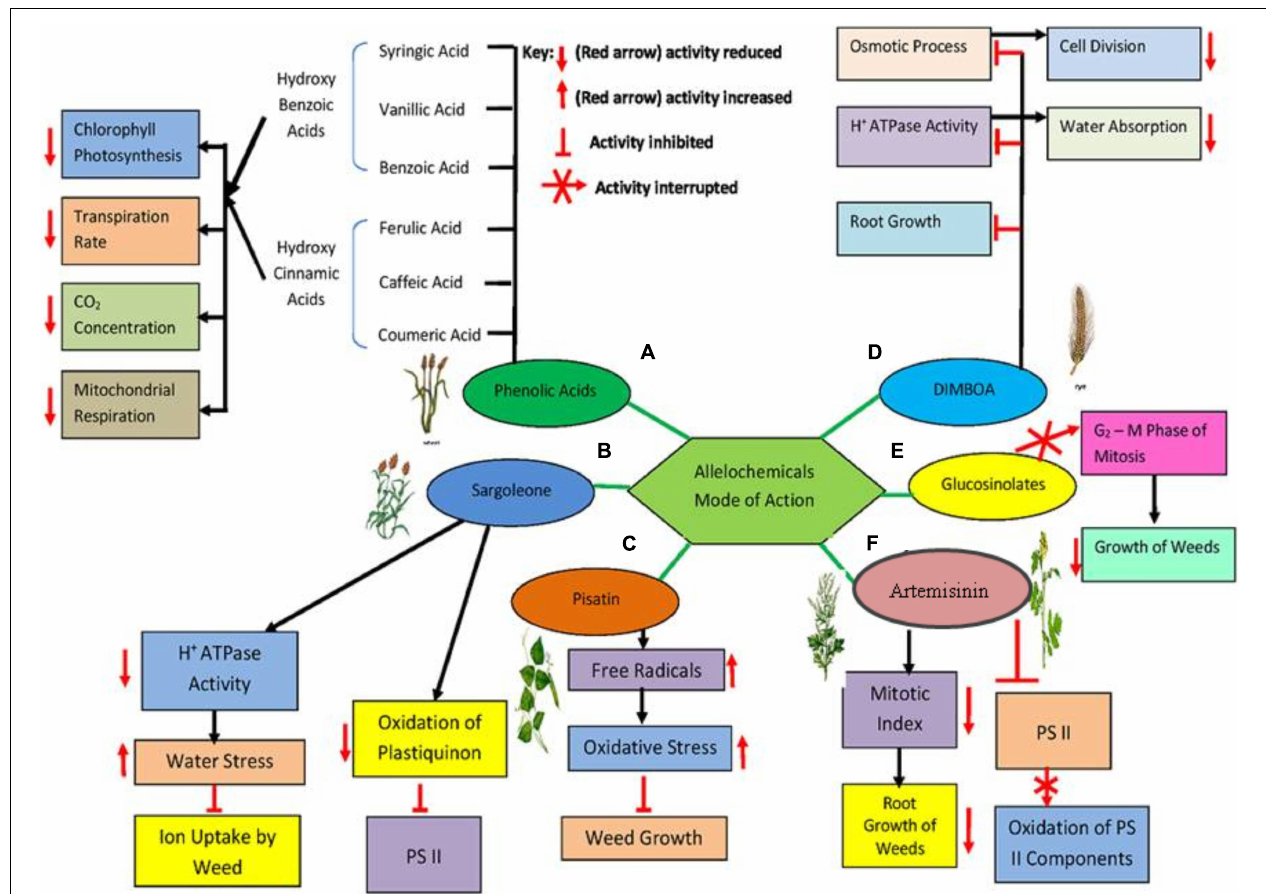
FIGURE 7 | A schematic diagram showing the mode of actions of selected allelochemicals to interfere with various biochemical pathways of weeds. (A) Interference of phenolics, i.e., hydroxyl benzoic and hydroxyl cinnamic acids, to suppress entire photosynthetic activity as well as mitochondrial respiration. (B) Reduction in ion uptake of weeds due to restrained ATPase activity and increased water stress along with blockage of photosystem II (PSII) induced by sorgoleone, an important allelochemical in sorghum. (C) Suppressed weed growth as a result of increased oxidative stress in weeds stimulated by pisatin occurring in pea. (D) Blockage of ATPase activity, osmotic process, and resulting repression of weed’s root growth due to DIMBOA from wheat and maize. (E) Glucosinate (allelochemical in mustard plant) induced reduction of mitotic cell cycle (G 2 -M phase). (F) Diminished mitotic index and activity of PSII intervened by artemisinin, the most significant allelochemical in artemisia. All these allelochemicals released from potent plants present them as a powerful source of natural